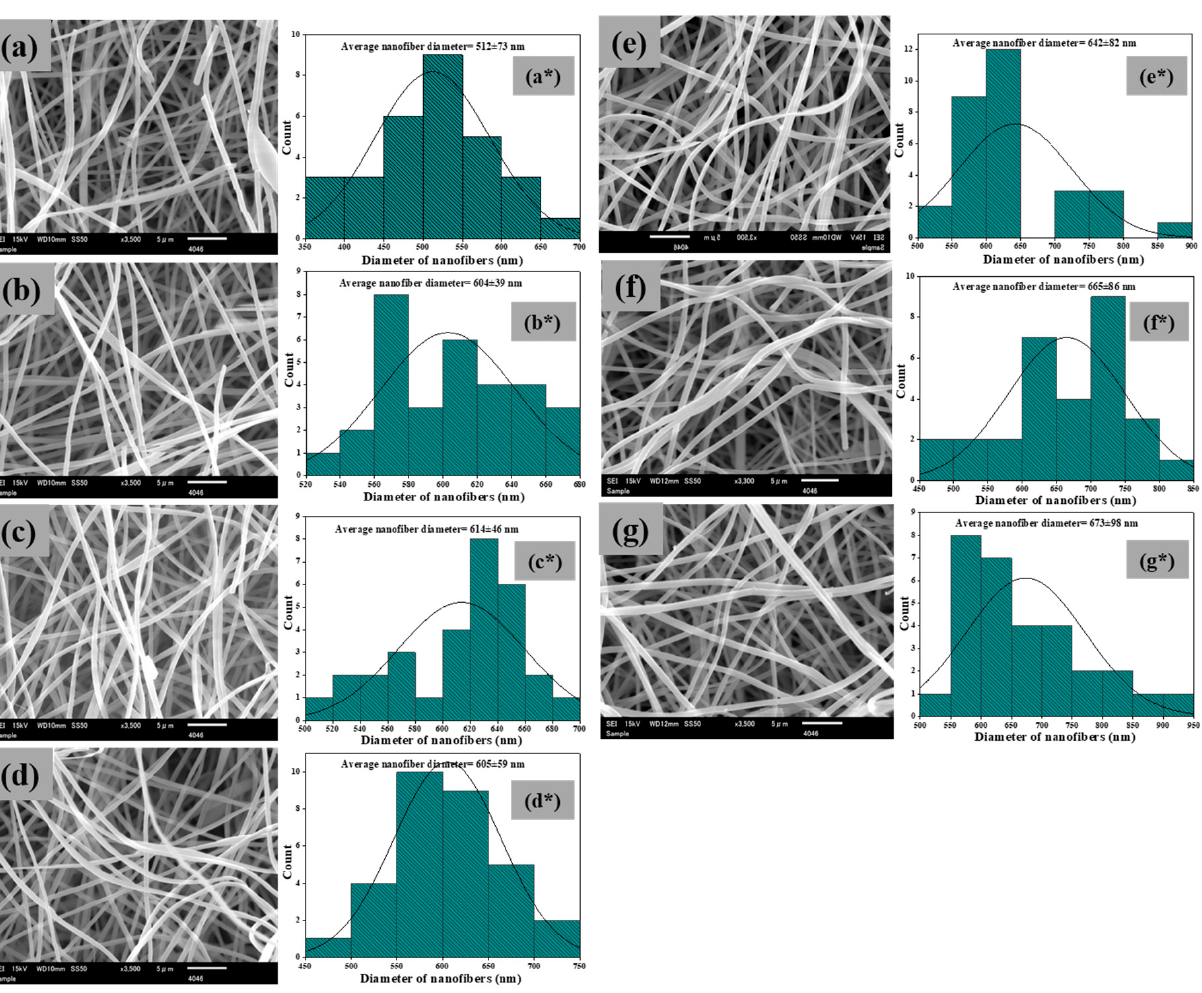
Figure 1. SEM images of PAN nanofiber ( a ), PAN/AgNPs1 ( b ), PAN/AgNPs2 ( c ), PAN/AgNPs3 ( d ), PAN/AgNPs4 ( e ), PAN/AgNPs5 ( f ), and PAN/AgNPs6 ( g ); nanofiber diameter distribution histograms of PAN nanofiber ( a* ), PAN/AgNPs1 ( b* ), PAN/AgNPs2 ( c* ), PAN/AgNPs3 ( d* ), PAN/AgNPs4 ( e* ), PAN/AgNPs5 ( f* ), and PAN/AgNPs6 ( g* ).